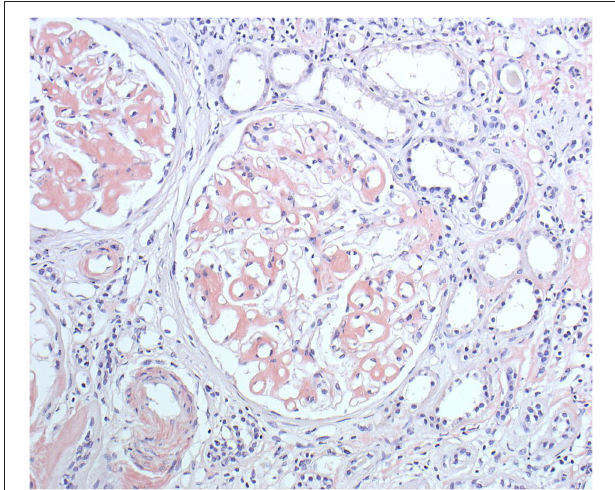
FIGURE 2 | Patient II/2 renal biopsy. Congo red staining showing amyloid deposits in the glomeruli, arterioles and also in the interstitium around the peritubular capillaries. (Courtesy of Assoc. Prof. E. Honsova Ph.D, Clinical and Transplant Pathology Centre, Institute for Clinical and Experimental medicine, Prague, Czech Republic).